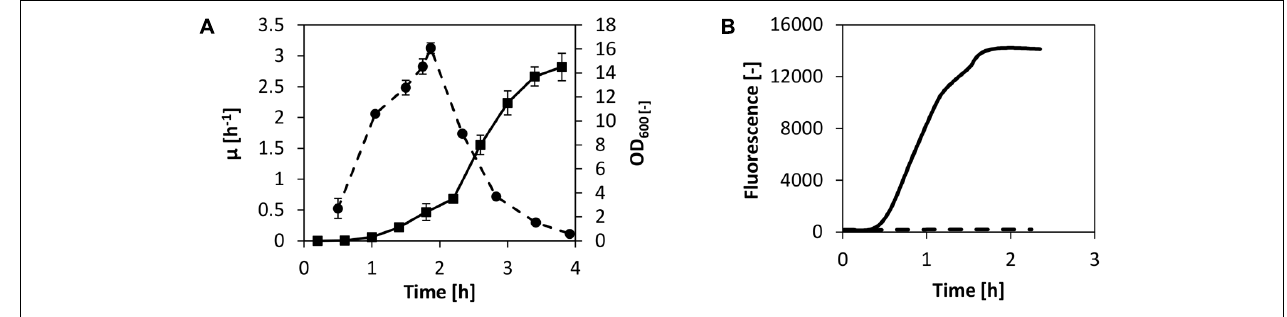
FIGURE 1 | CFPS from V. natriegens . (A) Shake flask cultivation of V. natriegens in BHIN media at 37 ◦ C. Depicted are the biomass (solid line) and the differential specific growth rate (dashed line). For lysate preparation, cells were harvested at maximum growth. Error bars denote standard deviations of three independent measurements. (B) Cell-free protein synthesis of eGFP using V. natriegens cell-free extract (solid line). The negative control without plasmid is also shown (dashed line).